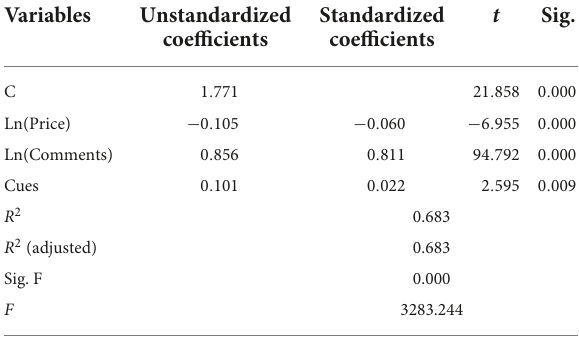
TABLE 2 Results of haptic cues influence in scarf presentation.